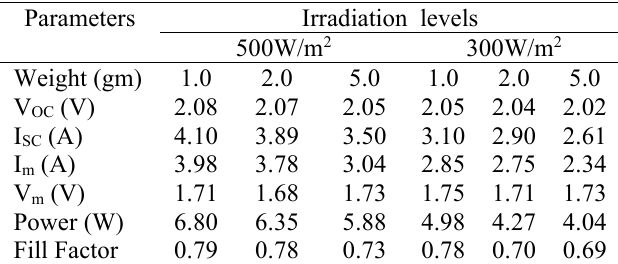
Table 3. Electrical performance parameters with Brick furnace dust at 500/300W/m 2